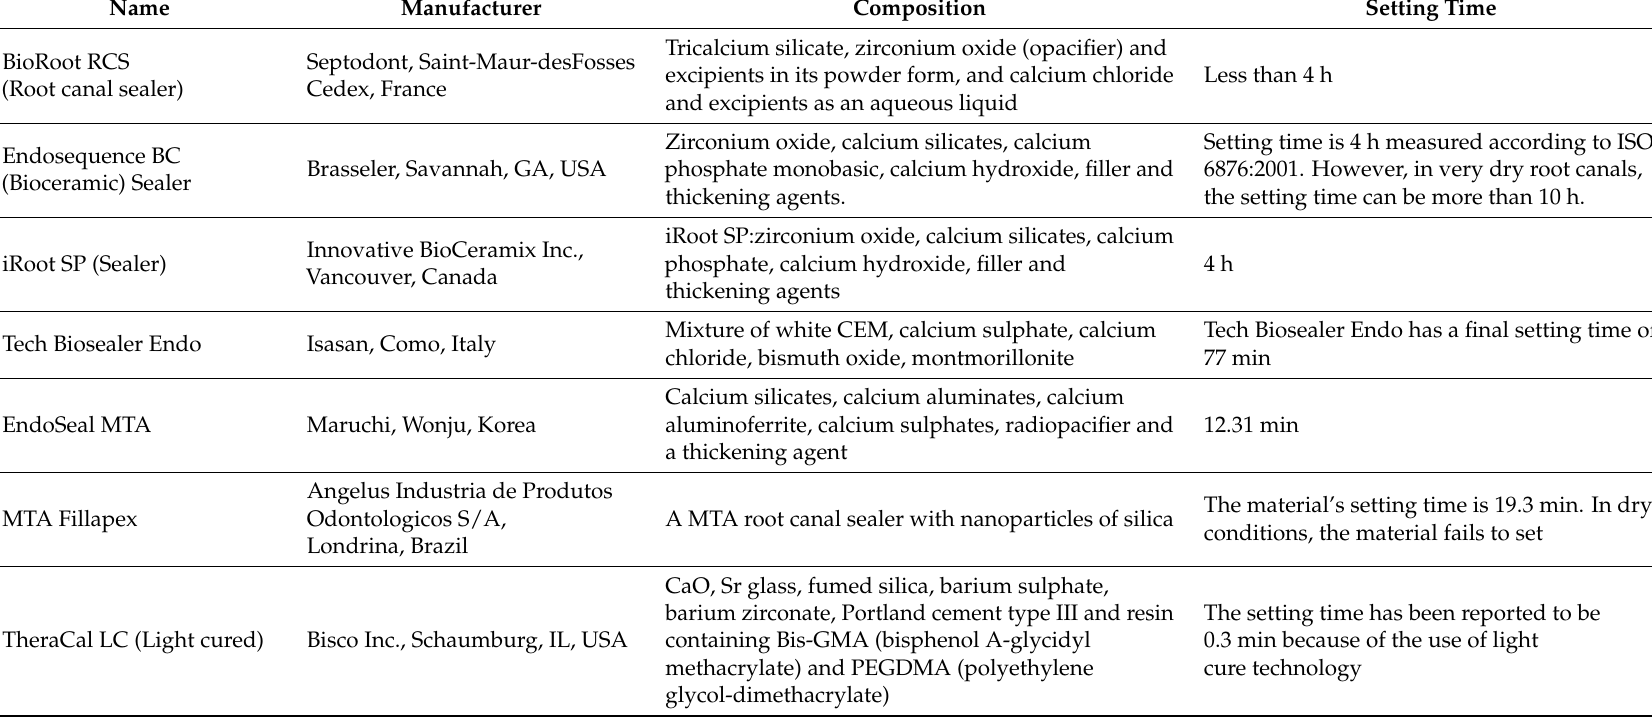
Table 3. Bioactive Endodontic Cements for root canal